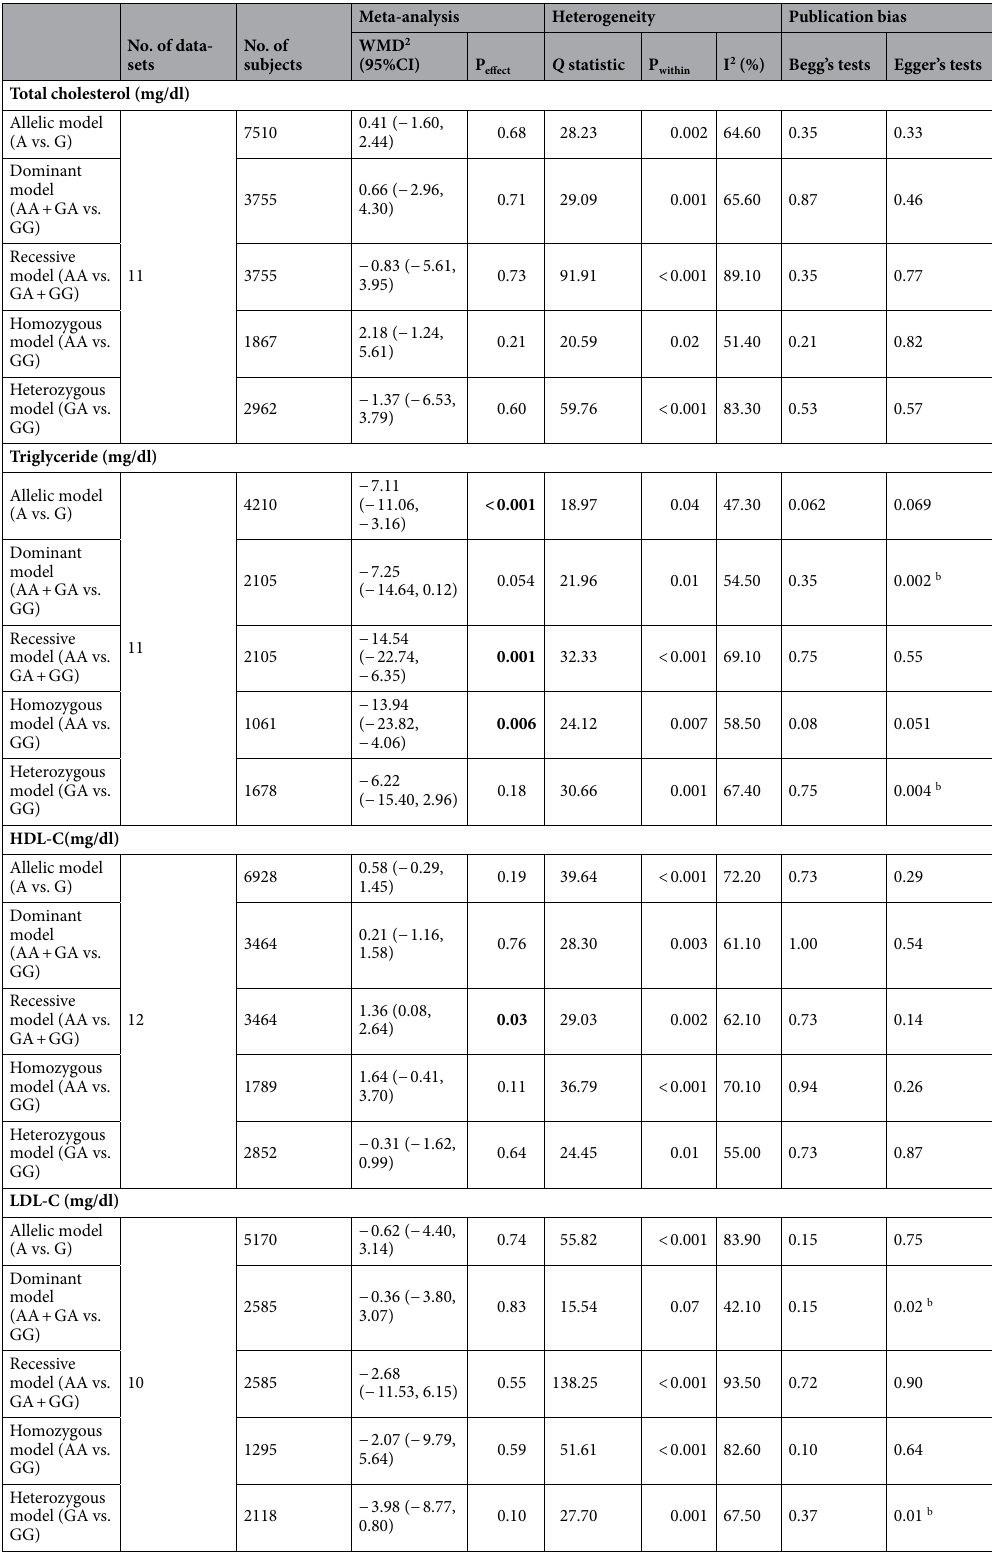
Table 3. The association between CD36 rs1761667 polymorphism and lipid profile. All analyses were conducted using a random-effects model a . Significant values are in bold. a All analyses were done using the random-effects model. b These values were unchanged using the trim and fill method. WMD, weighted mean difference; 95% CI, 95% confidence